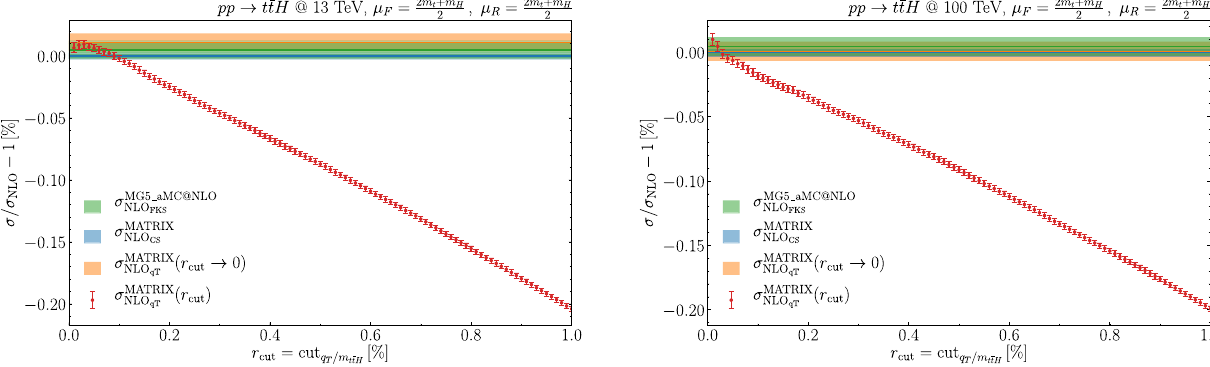
√ Fig. 1 The r cut dependence (data points) at s = 13 TeV (left) and 100 TeV (right) of the NLO total cross section computed by using q T subtraction. The bands show the extrapolated value at r cut → 0 and the NLO results from Madgraph5_aMC@NLO (using FKS subtraction) and Matrix (using dipole